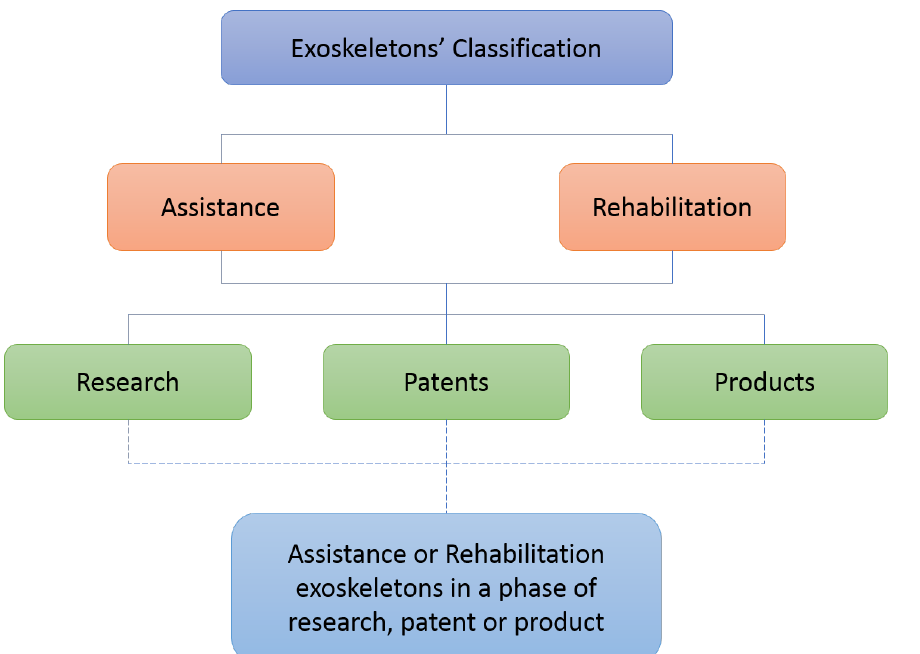
Figure 3. Structure followed in the Review Methodology section to find the exoskeletons used in this